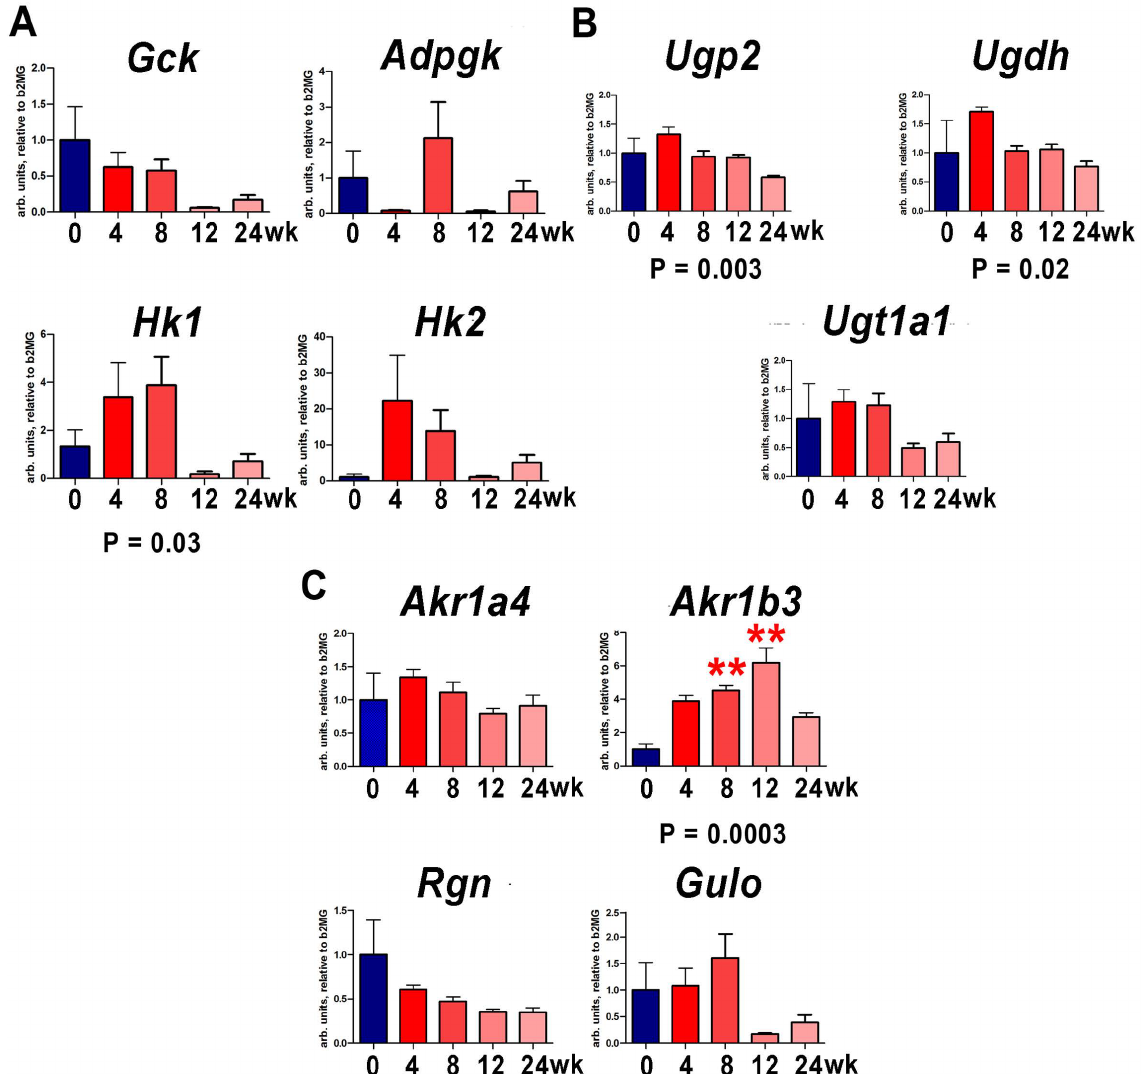
Figure 8. Expression of mouse genes involved in ascorbic acid synthesis from glucose and galactose after administration of 60% high-fat and choline-deficient amino-acid-defined diet. ( A ). The phospho- rylation of hexoses pathway. ( B ). The synthesis of glucuronic acid from glucose 1-phosphate pathway. ( C ). The synthesis of ascorbic acid from glucuronic acid pathway. ** = p < 0.01 compared to controls. p -values represent nonparametric ANOVA (Kruskal–Wallis)